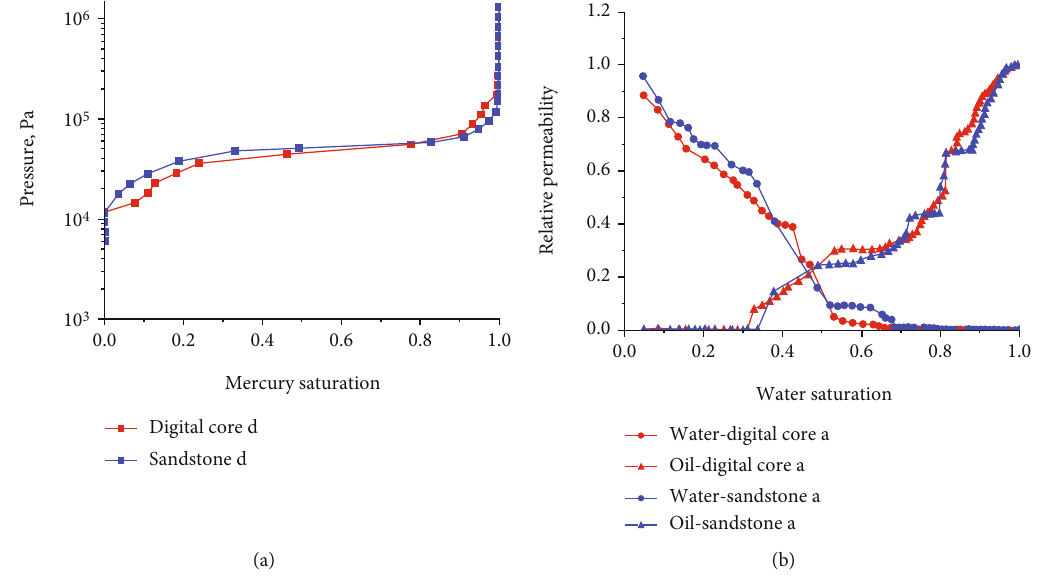
Figure 23: (a) Mercury injection and (b) oil-water two-phase fl ow simulation of digital core d and sandstone